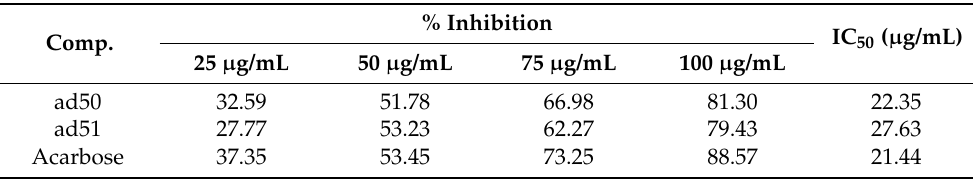
Table 51. Antidiabetic potential of the compounds ( ad50 – ad51 ) according to α -amylase inhibitory